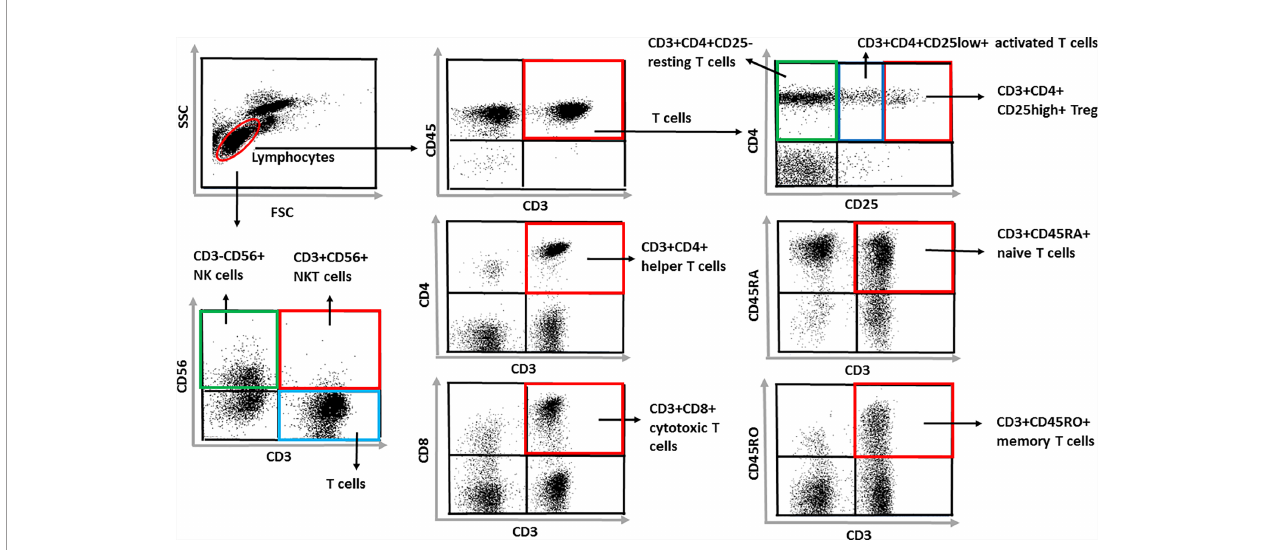
FIGURE 1 | Gating strategies. At least 10,000 cells were collected in the lymphocyte gate and analyzed. CD3+, CD4+, CD5+, CD8+ T cells, CD3+CD4+CD25- ” , CD3+CD4+CD25 low “ activated ” and, CD3+CD4+CD25 high “ regulatory ” T cells were detected and their absolute cell numbers were calculated. “ resting T helper cells We followed naive CD3+CD45RA+ and CD3+CD45RO+ memory T cell percentages and absolute cell counts, CD3+CD56+ NKT-like and CD56+ NK cell ratio and absolute cell counts. CD3/CD45 positive cells were further analyzed for their CD4, CD8 and CD25 expression. Naive and memory T cells were detected with simultaneous CD3/CD45RA/CD45RO staining, NK cells and NKT cells were analyzed from the lymphocyte gate based on their CD3/CD56 positivity. For each of the gated cell populations the percentages of cells were